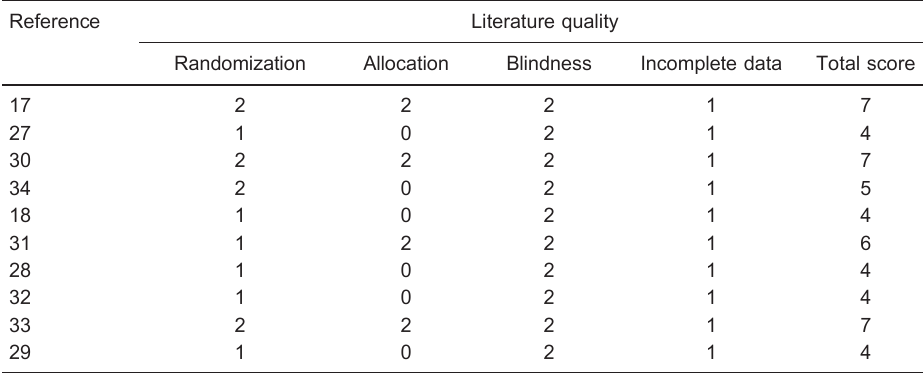
Table 2. Quality assessments of the included